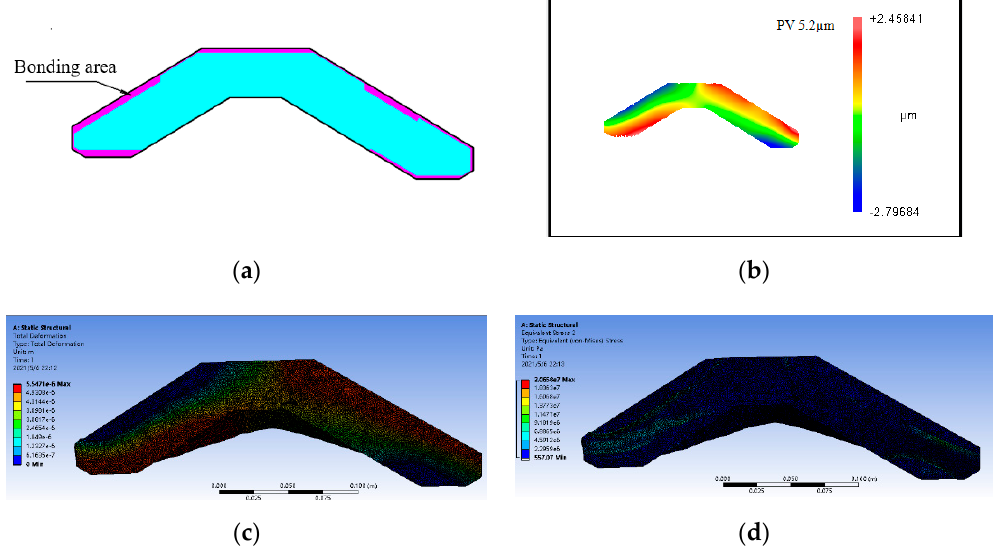
Figure 10. Clamping deformation simulation of a weak ‐ stiffness mirror: ( a ) bonding area; ( b ) measurement results of clamping deformation; ( c ) machining surface displacement distribution map; and ( d ) machining surface stress distribution map.